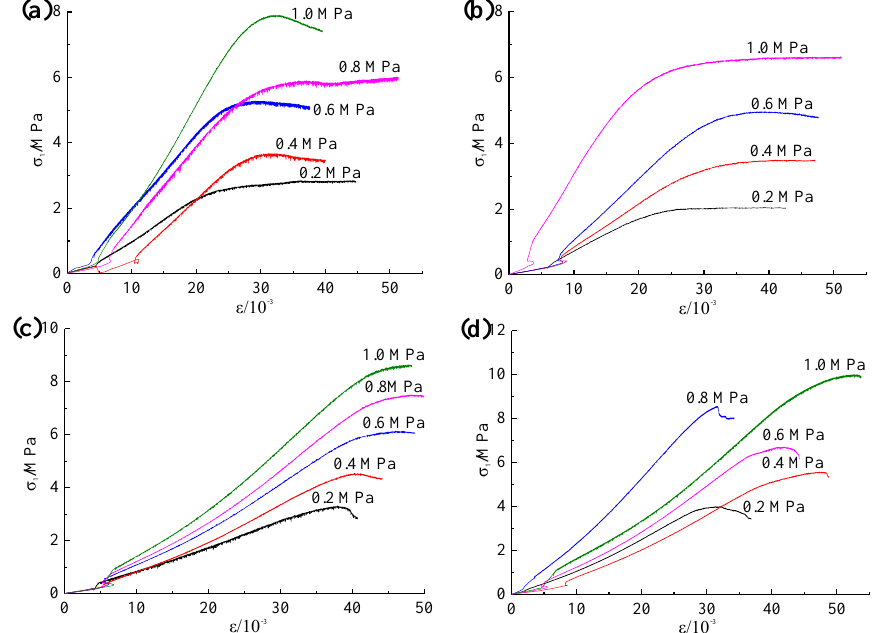
Figure 8. The triaxial compression stress–strain curves of briquettes with different particle sizes: ( a ) group A, ( b ) group B, ( c ) group C and ( d ) group D.